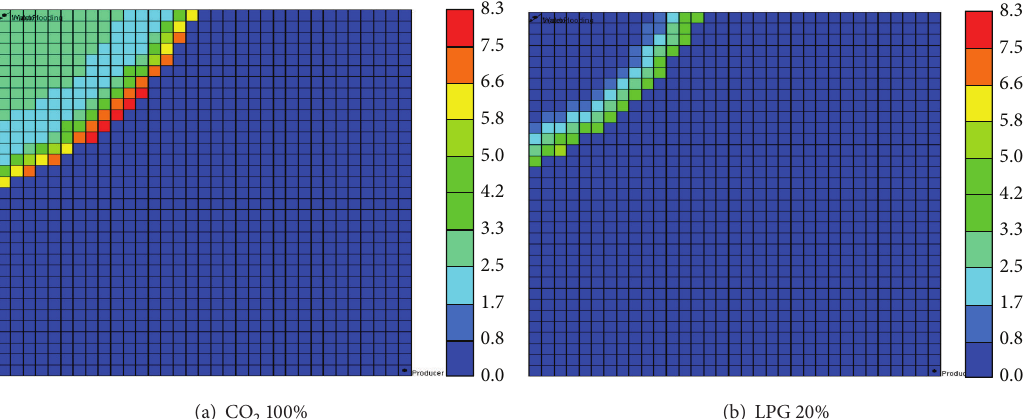
Figure 9: Interfacial tension between oil and gas phases with injected gas mole fraction after six months of gas injection (LPG composition: 63% propane and 37% butane).